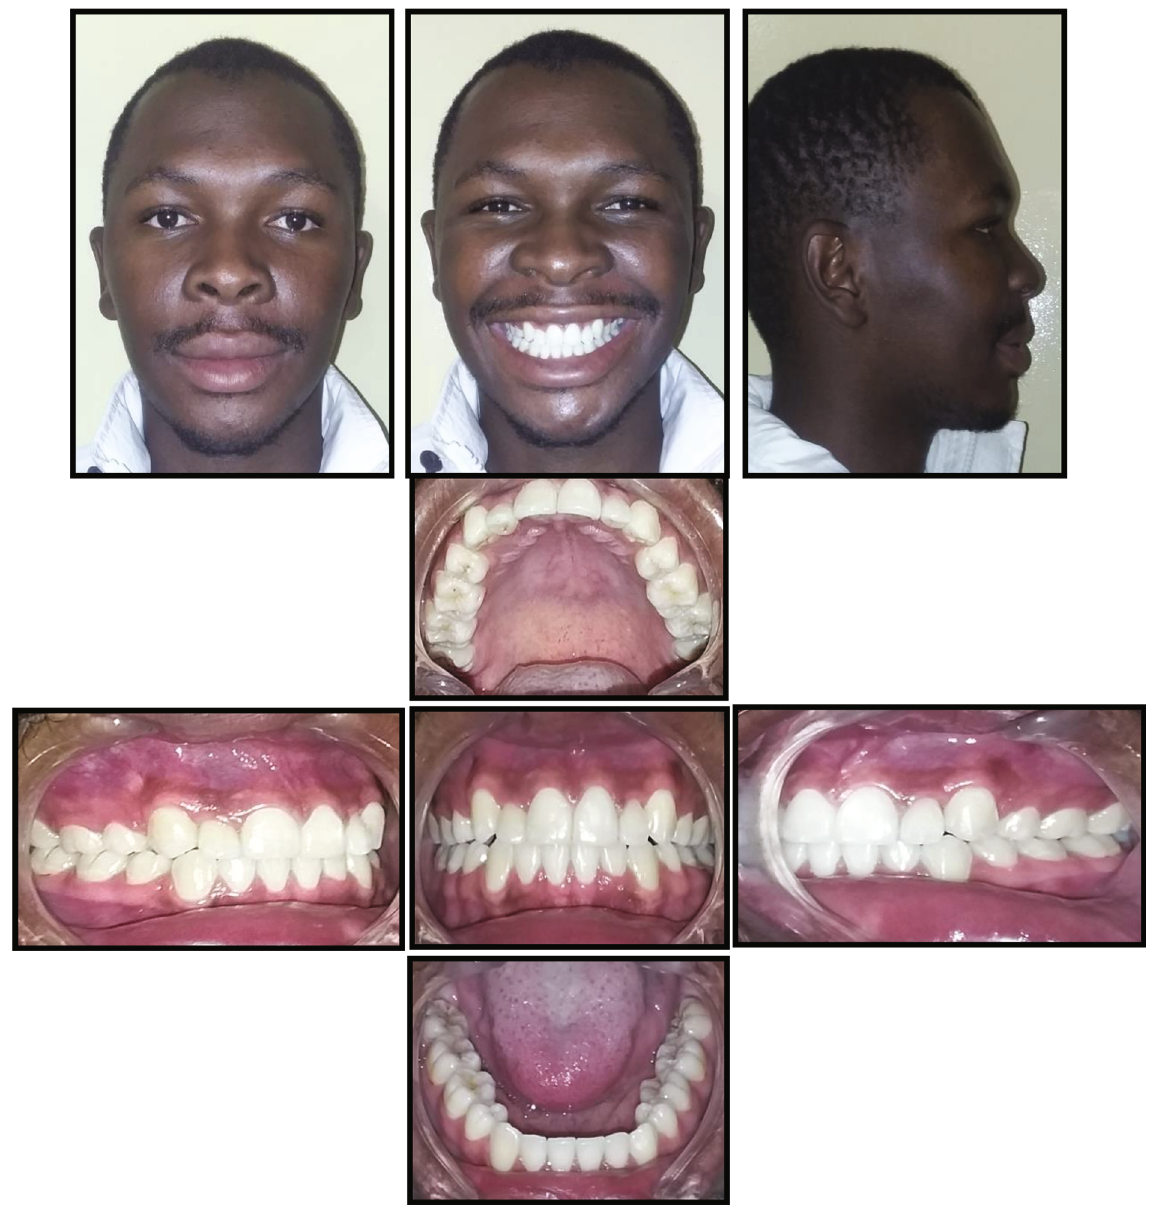
Figure 6: Postretention photographs 14-month